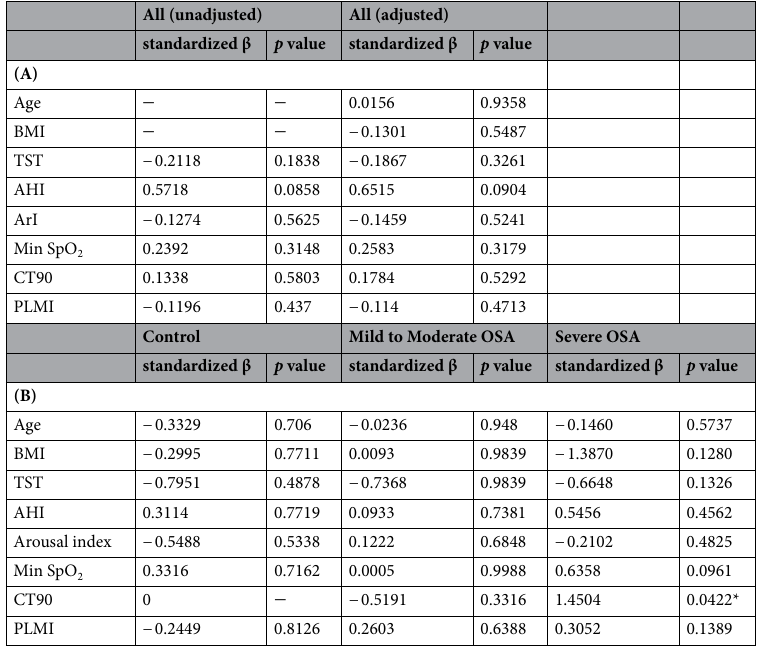
Table 4. Multivariate analysis in associated factors for Δ Negative Affect in the PANAS. AHI, apnea–hypopnea index; BMI, body mass index; CT90, percentage of cumulative time of blood oxygen saturation below 90% during sleep; Min SpO 2 , minimum saturation of percutaneous oxygen; OSA, obstructive sleep apnea; PANAS, positive and negative affect schedule; PLM, periodic limb movement; TST, total sleep time; *, p < 0.05.